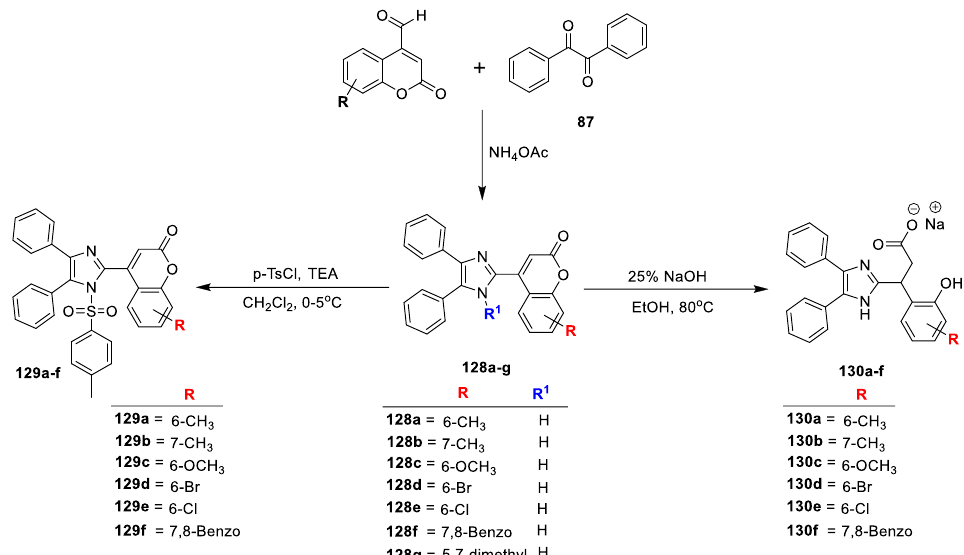
Scheme 27. Synthesis of the coumarin–imidazole hybrid and phenyl imidazole acrylates. Reproduced and adapted with permission from Ref. [43]. Copyright 2018, Springer